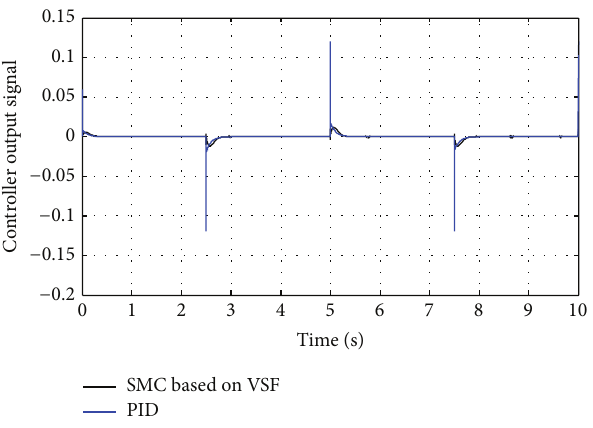
Figure 12: Comparison of the controllers output signals.